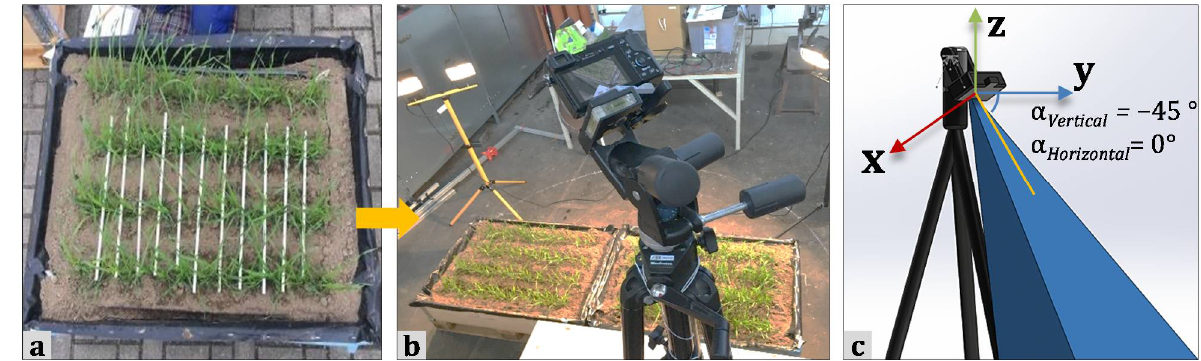
Figure 2. Demonstration of the main steps involved in the experimental for image acquisition with the mono camera system from different viewing angles and positions, showing ( a ) wheat plants seeded in the square pot, ( b ) overview of the experiment site, and ( c ) variable shooting adjustment of the mobile platform.